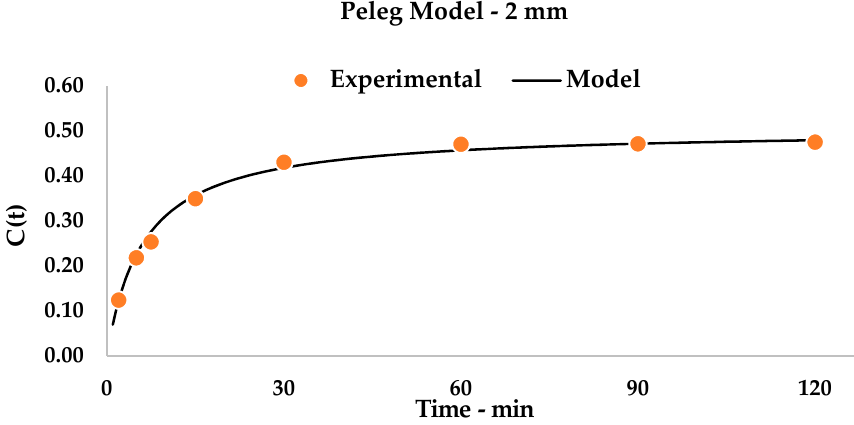
Figure 2. Kinetic Model, 6 mm matrix. Statistical values are reported in Table A1.